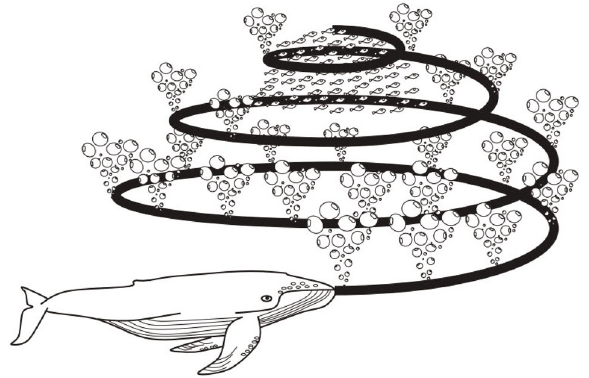
Figure 3: Bubble-net predation behavior.